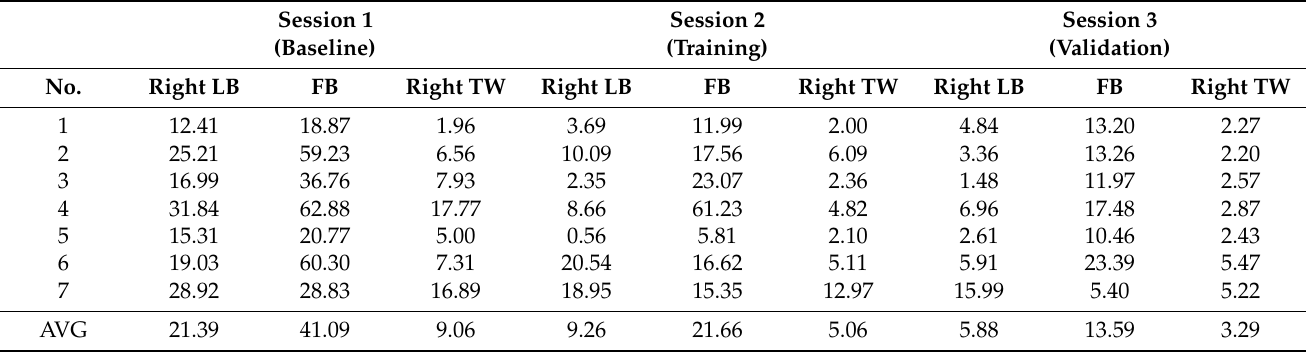
Table 2. Maximum peak values in degrees.